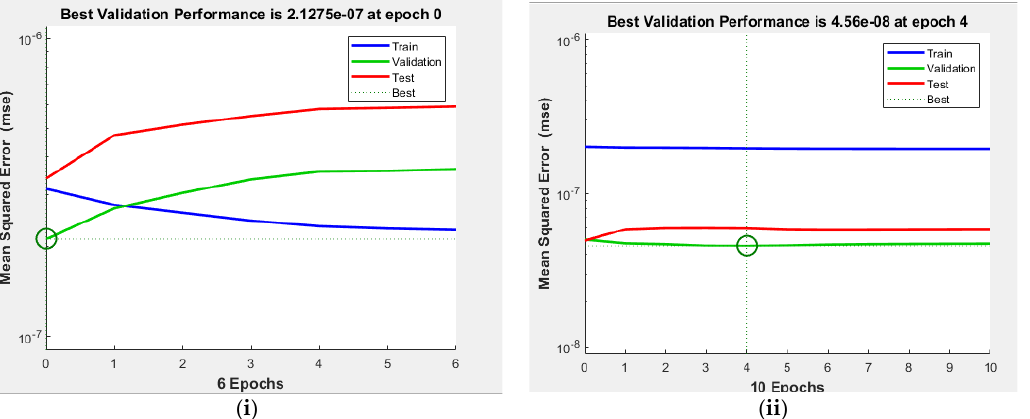
Figure 5. Mean square error for training, validation, and test plots for the selected ( i ) AN7-A, ( ii ) AN7-B.